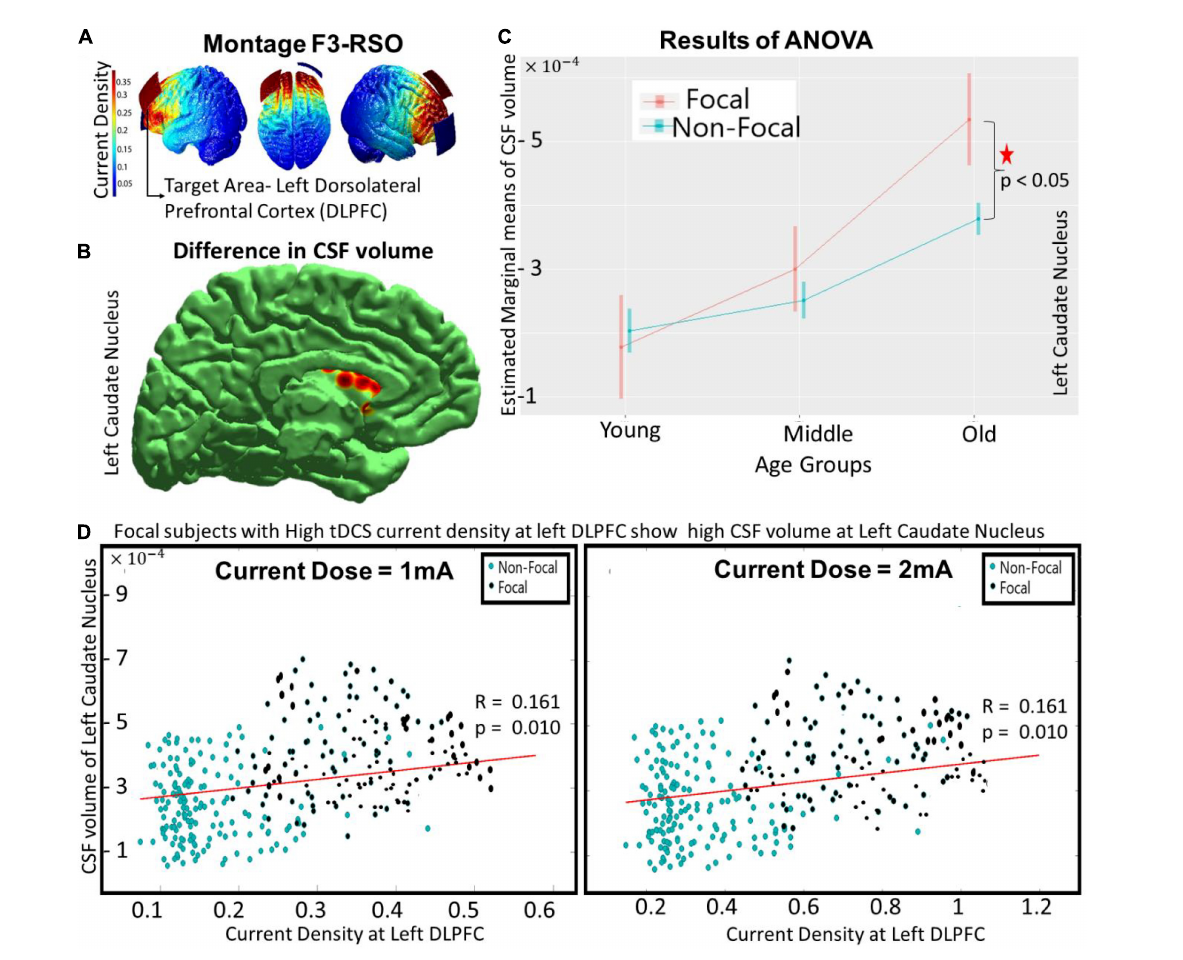
FIGURE1 The differences between focal and non-focal groups for the montage F3-RSO (at 1 mA) with— (A) showing the spread of current density over an individual’s brain with target ROI at left DLPFC, (B) reflecting the location of “focal” ROI at left caudate nucleus wherein significant ( p < 0.05) differences in CSF volume was observed between focal and non-focal groups, (C) highlighting that the difference was predominantly in the older group with focals having higher CSF volume, and (D) indicating that the CSF volume at focal ROI (left caudate nucleus) correlated (positively) with the current density at the target area (left DLPFC). The results remained similar as the current intensity was increased to 2 mA (as shown in D ).